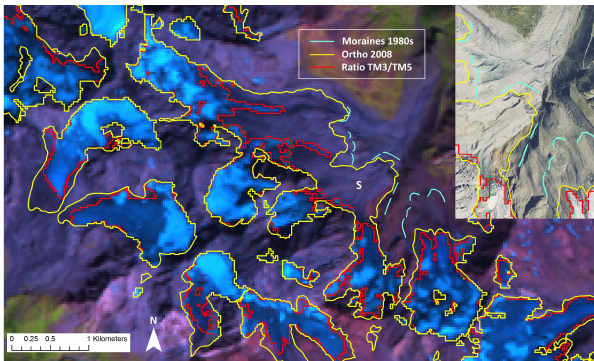
Fig. 4. Comparison of the automatic delineation of Solda glacier (S) from the thresholded band ratio image of 31 August 2009 (TM3/TM5; RGB composite of bands 5, 4, and 3 in the background) and post-processed delineation from aerial orthophoto (ortho 2008, in the inset). Lateral and terminal moraines built by this glacier in the mid-1980s (in light blue) were used for post-processing the au- tomatic delineation from the 1987 Landsat